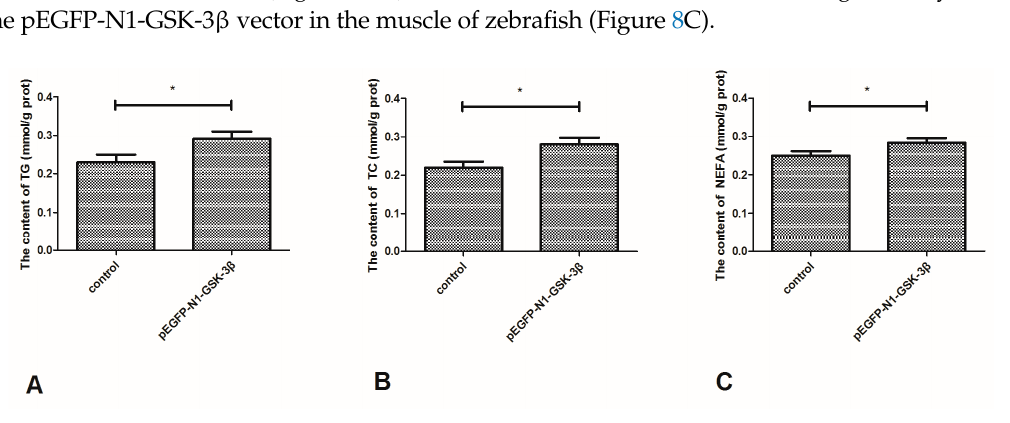
Figure 8. Effect of the pEGFP-N1-GSK-3 β vector on the levels of TG, TC, and NEFA in the muscle of zebrafish. ( A ) TG; ( B ) TC; ( C ) NEFA. Values are expressed as means ± s.e.m. ( n = 6). Statistically significant differences are denoted by an asterisk ( p < 0.05).